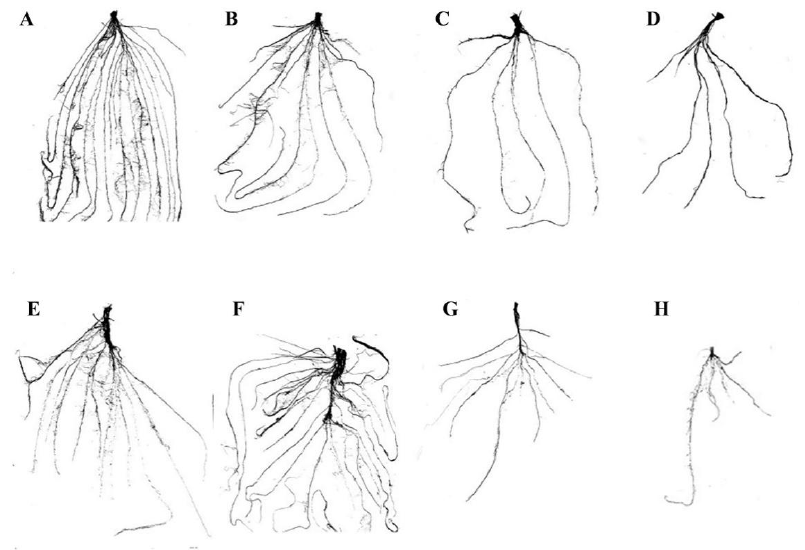
Figure 1. Root morphology of the two species under different shade treatments. Notes: ( A – D ) cor- respond to ‘Lark’ under CK, LS, MS, and HS, respectively, and ( E – H ) correspond to ‘SupraNova’ under CK, LS, MS and HS, respectively. CK = unshaded; LS = 35% shaded; MS = 70% shaded; HS = 92% shaded. Table 2. Effects of shade on root morphology of two turfgrass species.